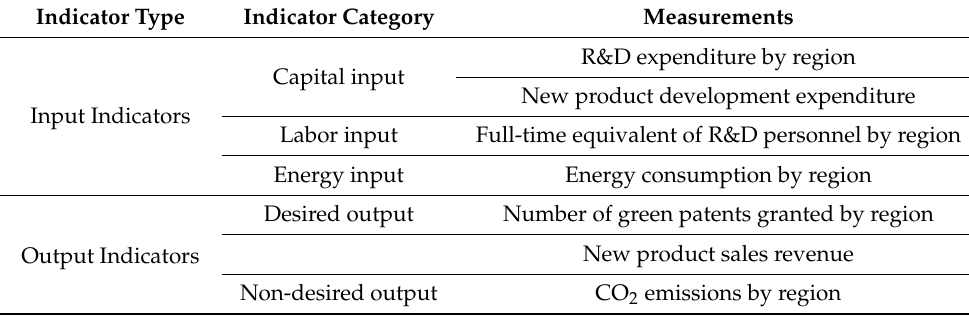
Table 1. Input–output table for